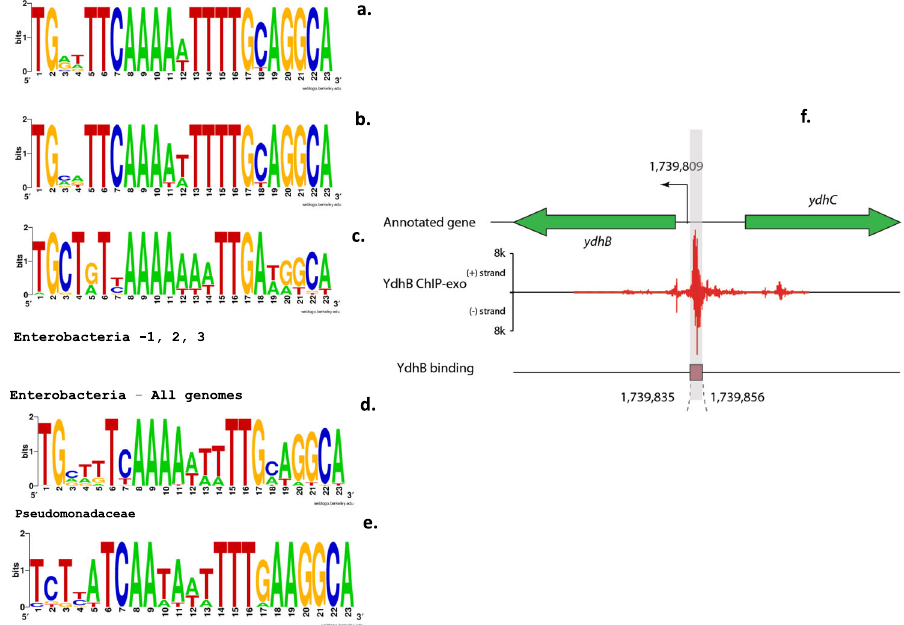
Fig. 2 The predicted PunR-binding site motifs in various groups of Enterobacteria and Pseudomonas spp. a – e The predicted PunR-binding site motifs in various groups of Enterobacteria and Pseudomonas spp. as identi fi ed by a phylogenetic footprinting approach. f Identi fi cation of the PunR binding region using ChIP-exo. Sequence logos were generated based on the multiple alignments of PunR-binding sites from respective groups of Enterobacteria or Pseudomonas genomes (see Supplementary Fig. 2) using the WebLogo tool. The representative groups for Enterobacteria-1, 2, 3 and Pseudomonadaceae are described in Supplementary Fig. 2.